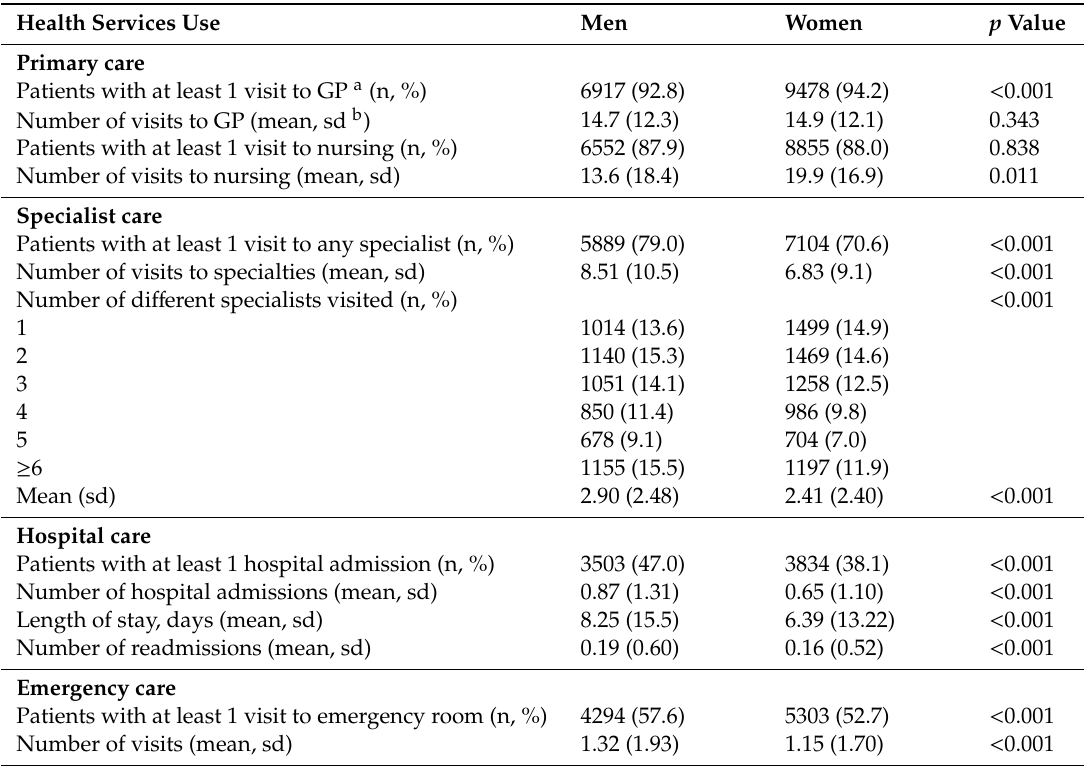
Table 4. Di ff erences in the pattern of utilization of health services in men ( n = 7454) and women ( n = 10,062) with heart failure during the year of study. Age-adjusted healthcare use rates are shown.